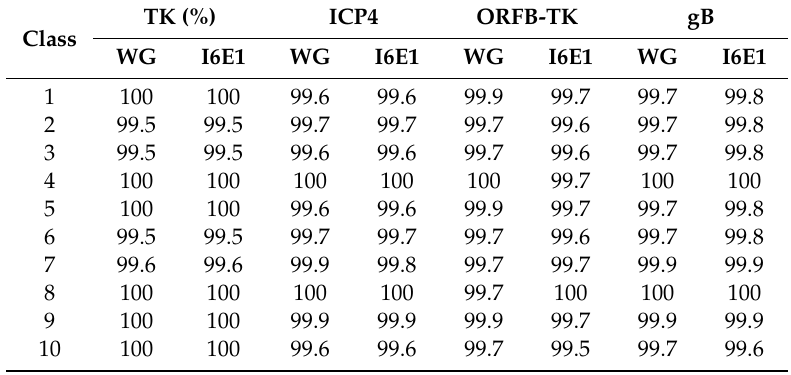
Table 1. Sequence analysis of epidemic strain I6E1 and commercial vaccine strain WG. TK (%) ICP4 ORFB-TK Class